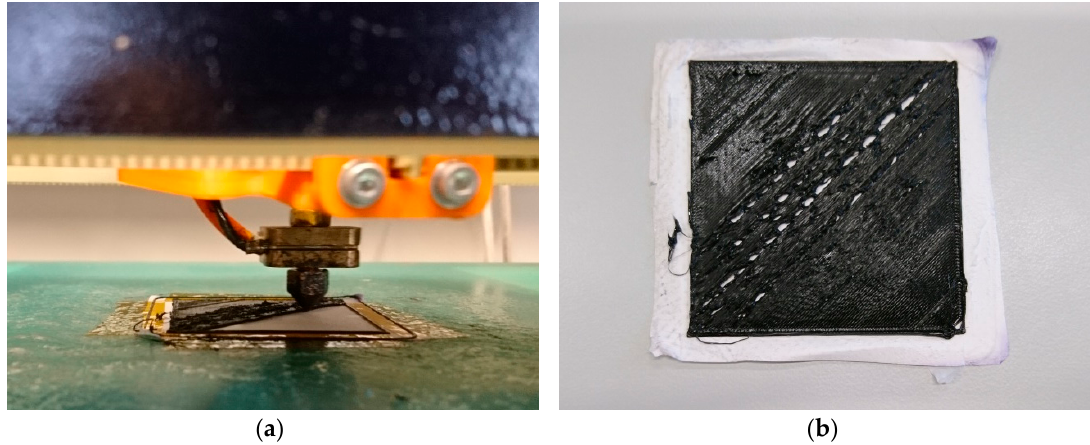
Figure 3. 3D printing squares of dimensions 40 mm × 40 mm on nanofiber mats previously dipped in soap water: ( a ) rough surface for a too large distance between nanofiber mat and printing nozzle; ( b ) 3D printed layer with uneven surface and even several not closed areas near the diagonal, i.e., along the longest lines, due to a too large distance between nozzle and nanofiber mat.